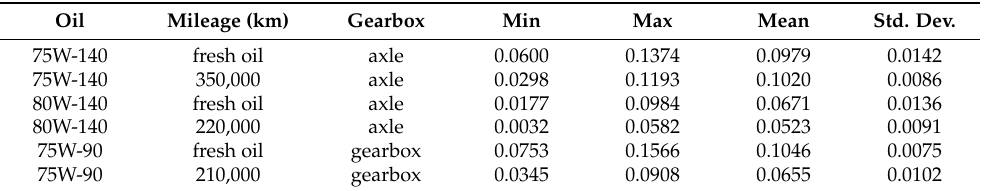
Table 1. Descriptive statistics of the friction coefficient obtained in the tests determining the lubricity of gear oils.